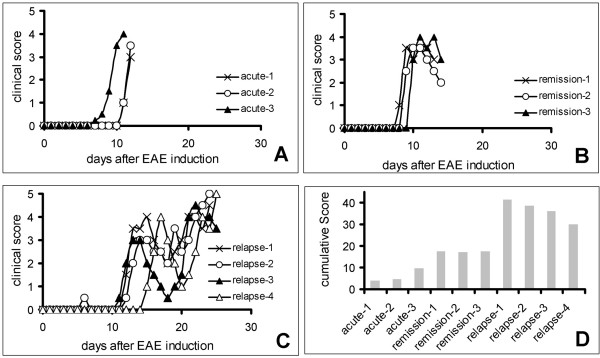
Summary of the clinical courses and cumulative scores of the DA rats chosen for the microarray expression study. A) acute phase, B) recovery phase, C) relapsing phase, D) cumulative disease scores (area under the curve) of the examined animals.